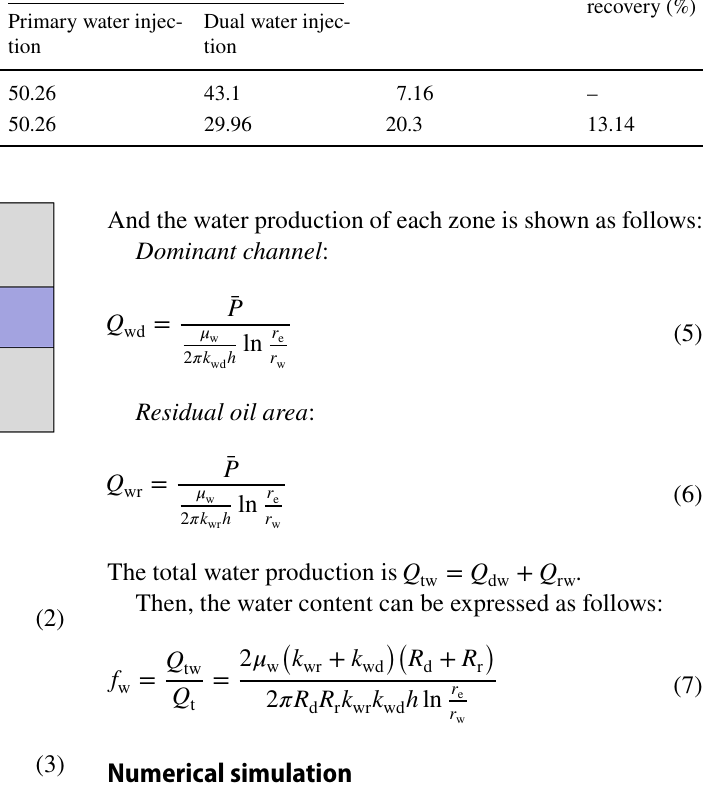
Table 1 Remaining oil saturation and enhanced oil recovery in different modes